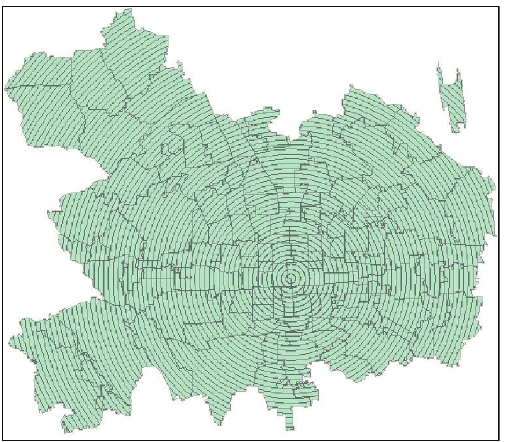
Figure 4: A sketch map of the zonal system of Beijing with a system of concentric